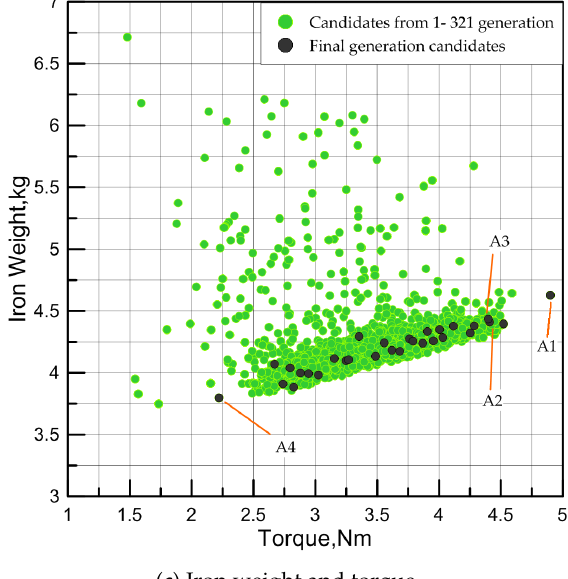
Figure 4. Objective functions results for 8/6